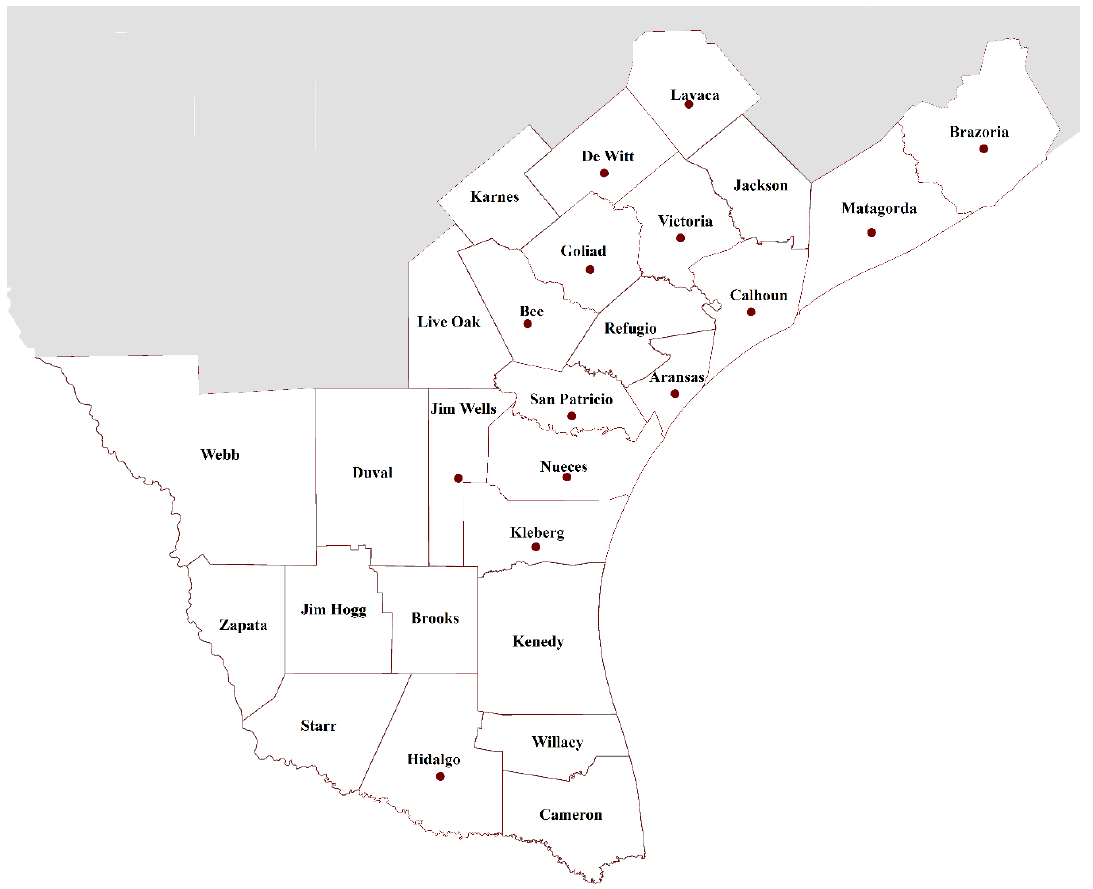
Figure 1. Program coverage area (14 of 27 South Texas counties in which the Diabetes Education Program was offered were marked with a red dot).